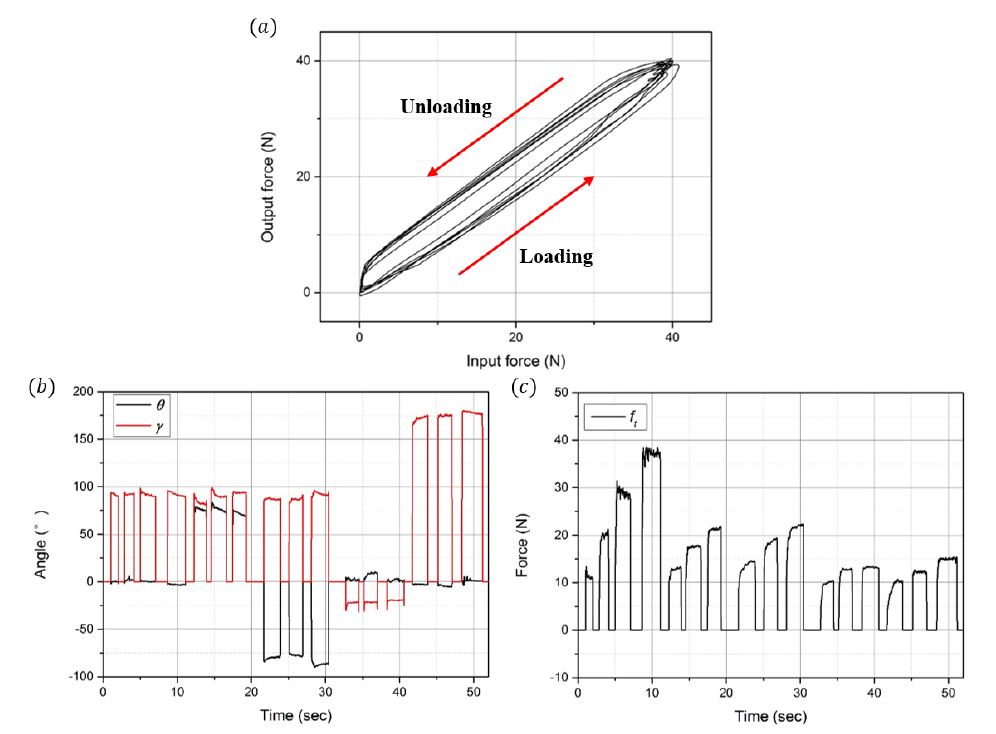
Figure 12. Hysteresis graph and estimation of the angles and magnitude of the applied forces. ( a ) Hysteresis graph of the developed sensor. ( b ) Position angle ( θ ) and direction angle ( γ ) of the applied forces. ( c ) Magnitude of the applied forces.